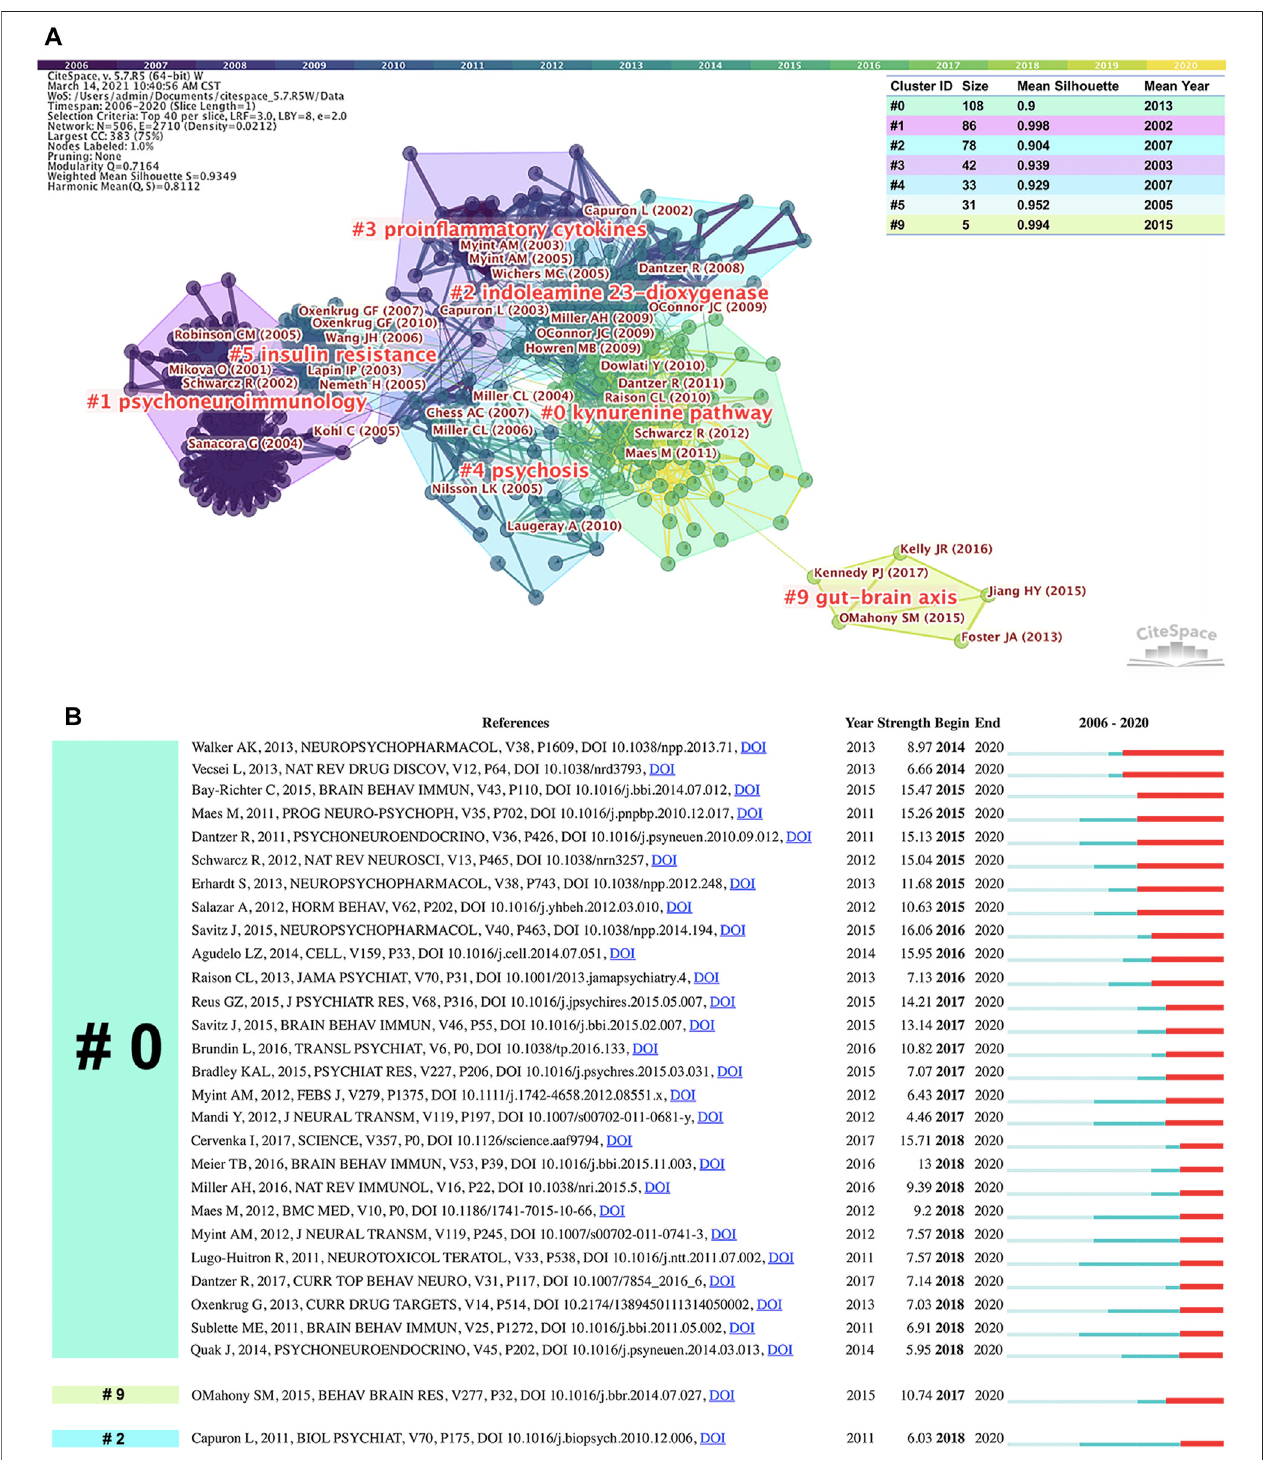
FIGURE 9 | | (A) Cluster visualization of the co-citation network of references via Citespace, together with the details and the top fi ve representative references of the generated clusters (B) The references with the strongest currently ongoing citation bursts in this fi eld. The red bars indicate the duration of the burst and re fl ect references cited frequently; the green bars indicate references cited infrequently.